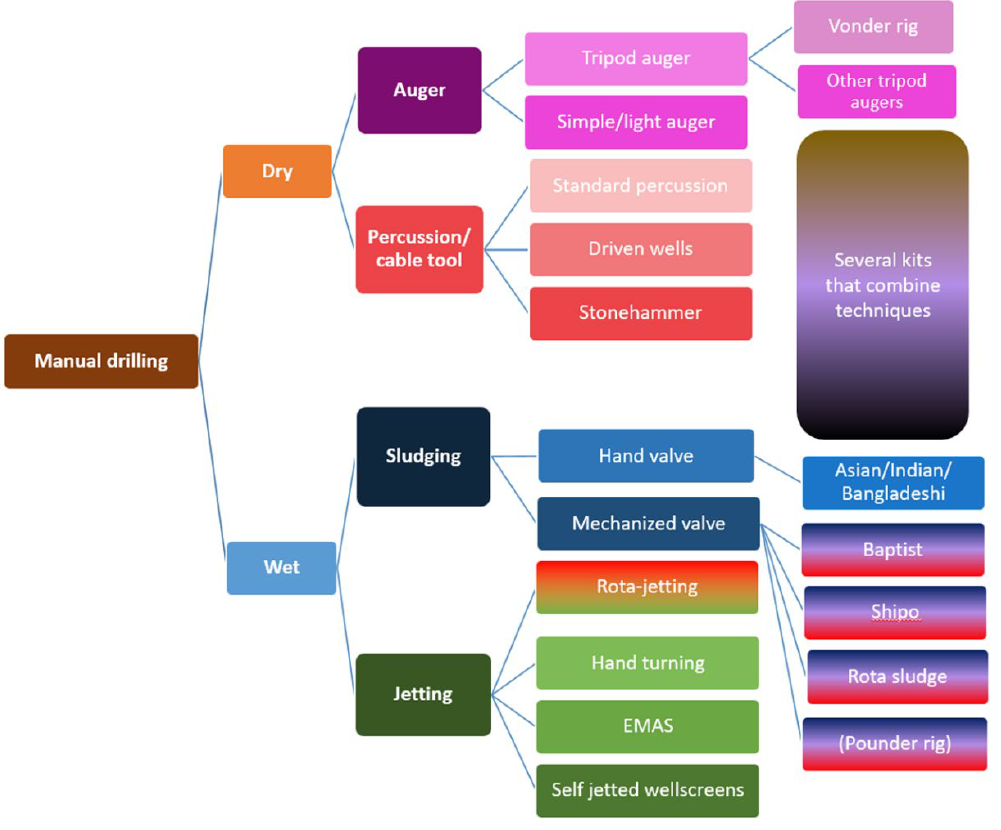
Figure 2. Manual drilling family tree [41]. Table 3. Suitability and limitations of manual drilling